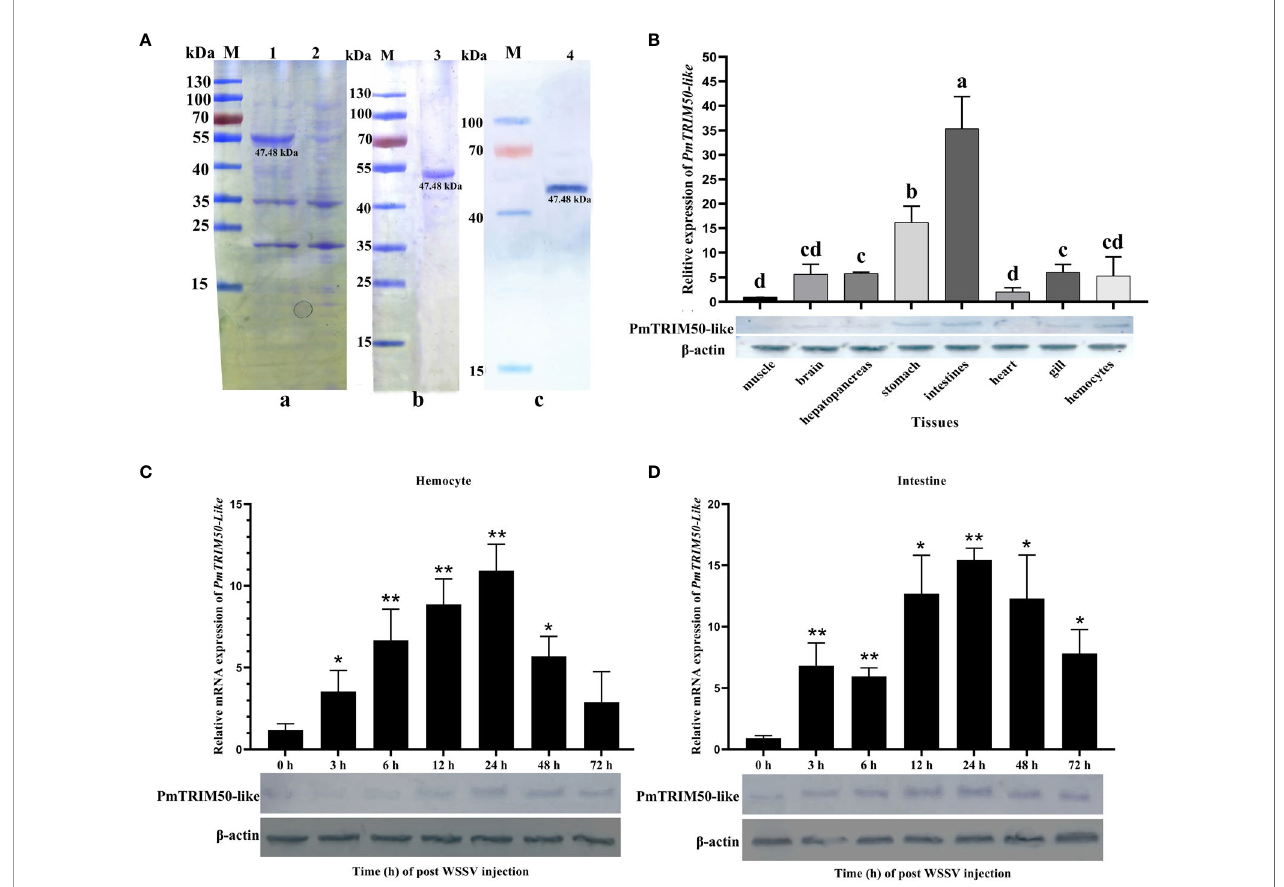
FIGURE 1 | PmTRIM50-like was upregulated in shrimp by WSSV infection. (A) Expression of recombinant PmTRIM50-like in E. coli and protein puri fi cation: (a) SDS-PAGE of induced PmTRIM50-like; Lane M, molecular weight marker; 1, recombinant protein of PmTRIM50-like at 12-h-induced; 2, recombinant PmTRIM50-like protein of none-induced. (b) SDS-PAGE analysis of puri fi ed PmTRIM50-like; Lanes M, molecular weight marker; 3, puri fi ed PmTRIM50-like protein. (c) Western blotting of PmTRIM50-like; Lane M, molecular weight marker; Lane 4, 12-h-induced PmTRIM50-like protein. (B) Tissue distribution of PmTRIM50-like was analyzed by qRT-PCR (upper panel) and western blotting (lower panel). Different lowercase letters indicate statistically signi fi cant differences ( P < 0.05 ). (C, D) Expression patterns of PmTRIM50-like mRNA and protein were detected by qRT-PCR (upper panel) and western blotting (lower panel) in hemocyte (C) and intestine (D) after WSSV challenge. b -actin was used as an internal reference. Asterisks indicate signi fi cant differences (* P< 0.05 and ** P <0.01 ) compared with values in the control group. Error bars represent mean ± S.D. of three independent PCR ampli fi cations and quanti fi